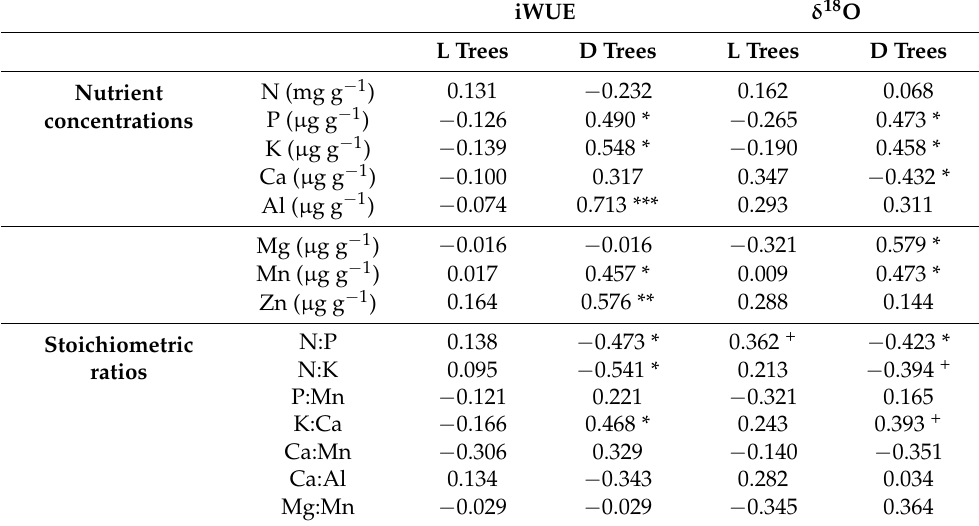
Table 2. Pairwise correlations between detrended isotopic signals (intrinsic water-use efficiency (iWUE) and oxygen isotope composition ( δ 18 O)) and nutrient concentrations and stochiometric ratios. The Spearman ρ statistic and associated p -value ( + p < 0.1; * p < 0.05; ** p < 0.01; *** p < 0.001) is shown for pair of variables for living (L) and dead (D)